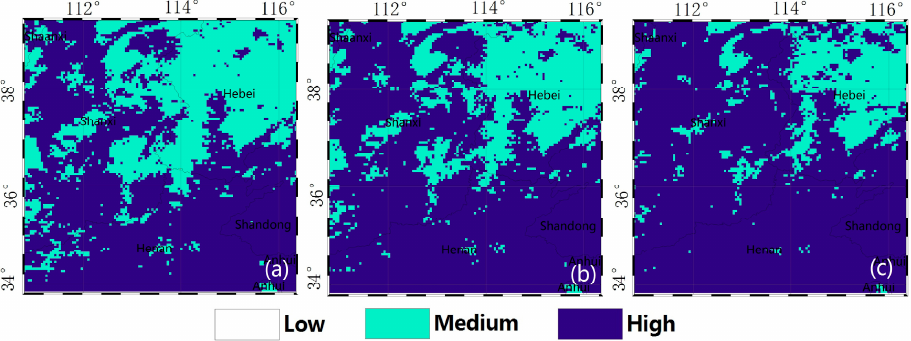
Figure 11. EDR data quality simulation results over the NCP under different aerosol loading: ( a ) AOD = 0.1, ( b ) AOD = 1, and ( c ) AOD = 2.